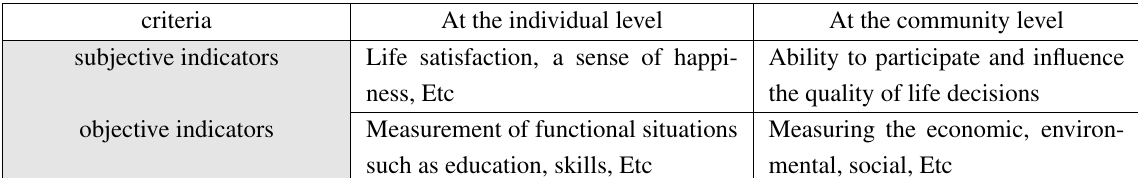
Table 5. Subjective and objective indicators